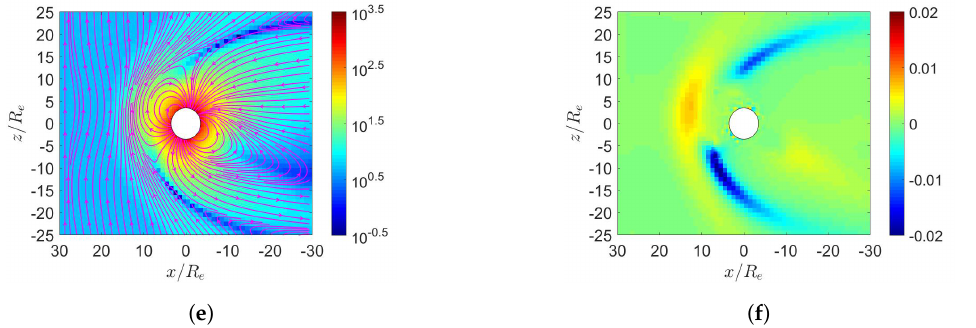
Figure 4. Distributions around magnetosphere of Earth. ( a ) n (cm − 3 ), ( b ) ¯ u xz (km/s), ( c ) magnetosonic